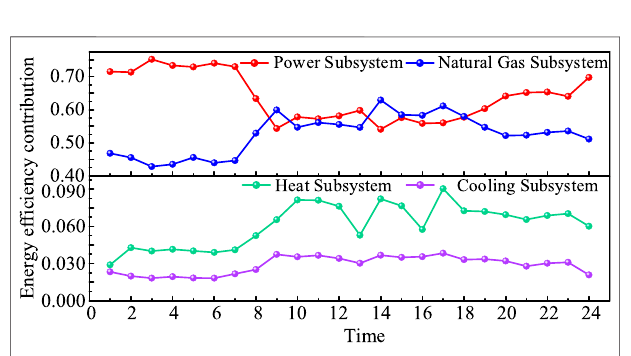
FIGURE 5 | Curves of energy ef fi ciency contribution in Phase II.